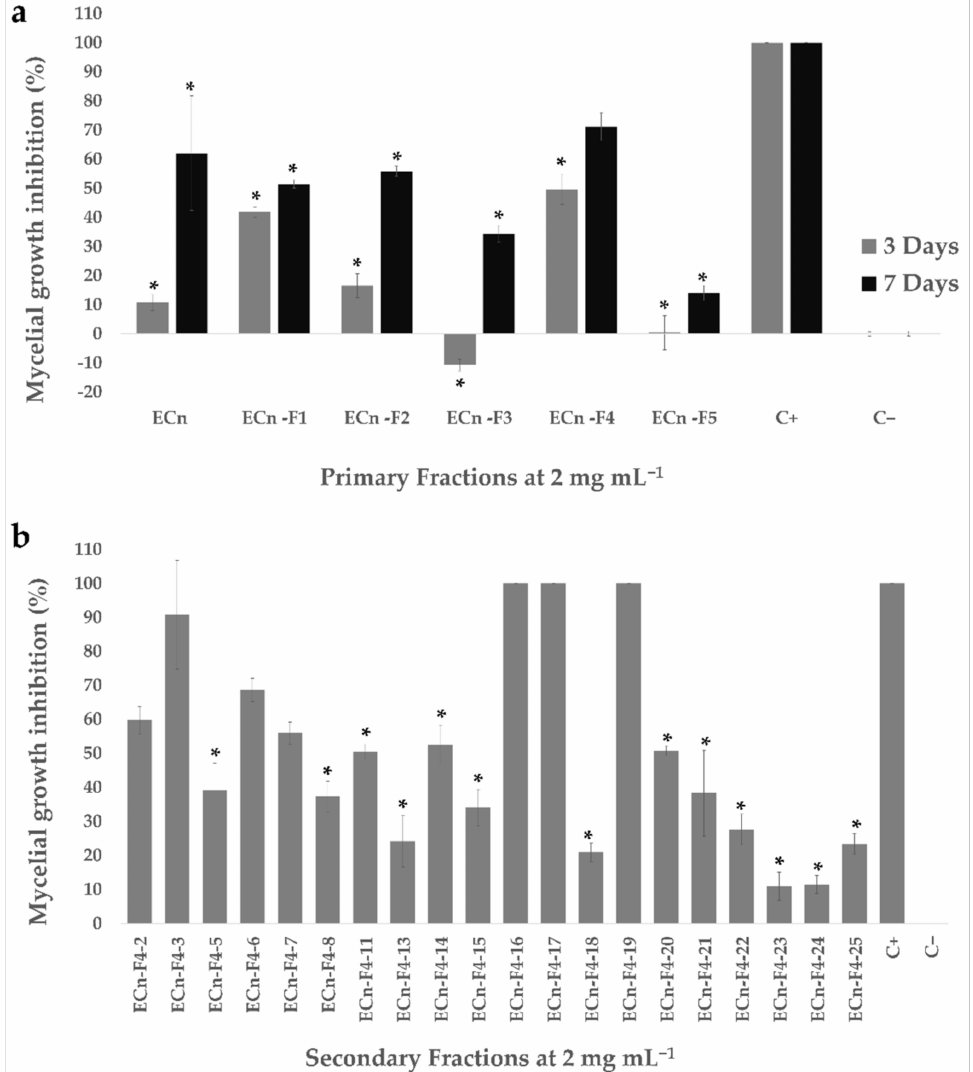
Figure 1. Mycelial growth inhibition displayed by primary and secondary fractions of C. noctur- num against F. solani . ( a ) Percentage of inhibition of F. solani growth exposed to primary fractions (2 mg mL − 1 ) evaluated three and seven days post-inoculation. Data are the average ± standard error ( n = 3). Asterisk (*) indicates significant difference compared to positive control (thiabendazole 2 mg mL − 1 ; C+), p < 0.05, Kruskall-Wallis, Mann-Whitney post-hoc test with Bonferroni adjustment. The negative control (C − ) was the vehicle (H 2 O-MeOH in a 15:85 ratio) where samples were dis- solved. Supporting material is shown in Supplementary Figure S1. ( b ) Percentage of inhibition of F. solani growth exposed to secondary fractions from ECn-F4 (2 mg mL − 1 ). Data are the average ± standard error ( n = 3). Asterisk (*) indicates significant difference compared to positive control (thi- abendazole 2 mg mL − 1 ; C+), p < 0.05, Kruskall-Wallis, Mann-Whitney post-hoc test with Bonferroni adjustment. The negative control (C − ) was the vehicle (H 2 O-MeOH in a 15:85 ratio) where samples were dissolved. Supporting material is shown in Supplementary Figure